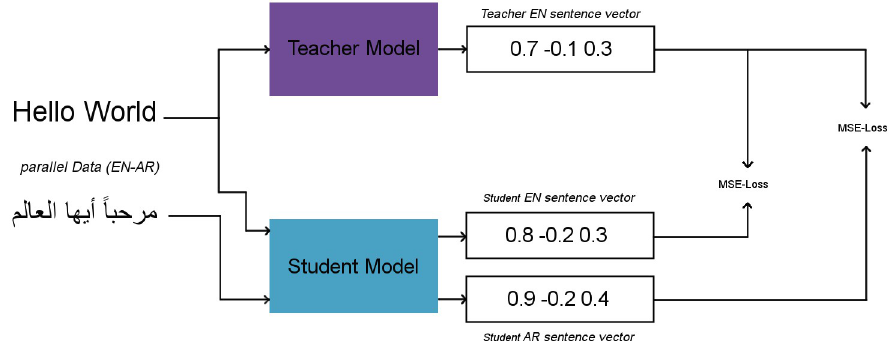
Fig 2. Given parallel data from two languages, a student model can be trained such that the generated vectors for the two languages sentences are close to the teacher language sentence vector.